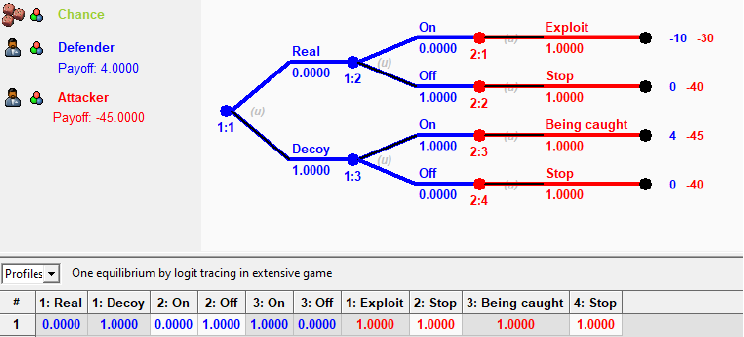
Figure 8. Results of the dominance for N 10 .